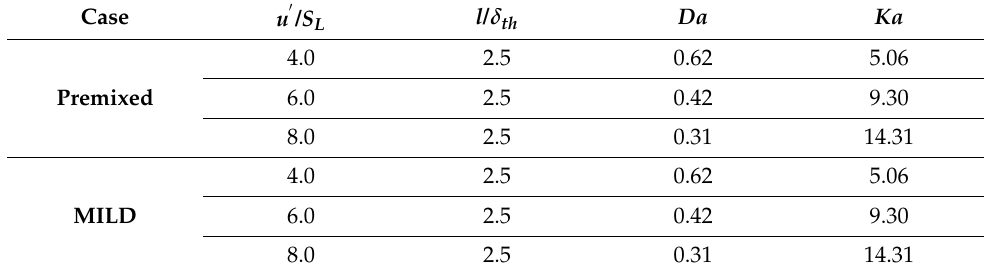
Table 2. Initial Turbulence